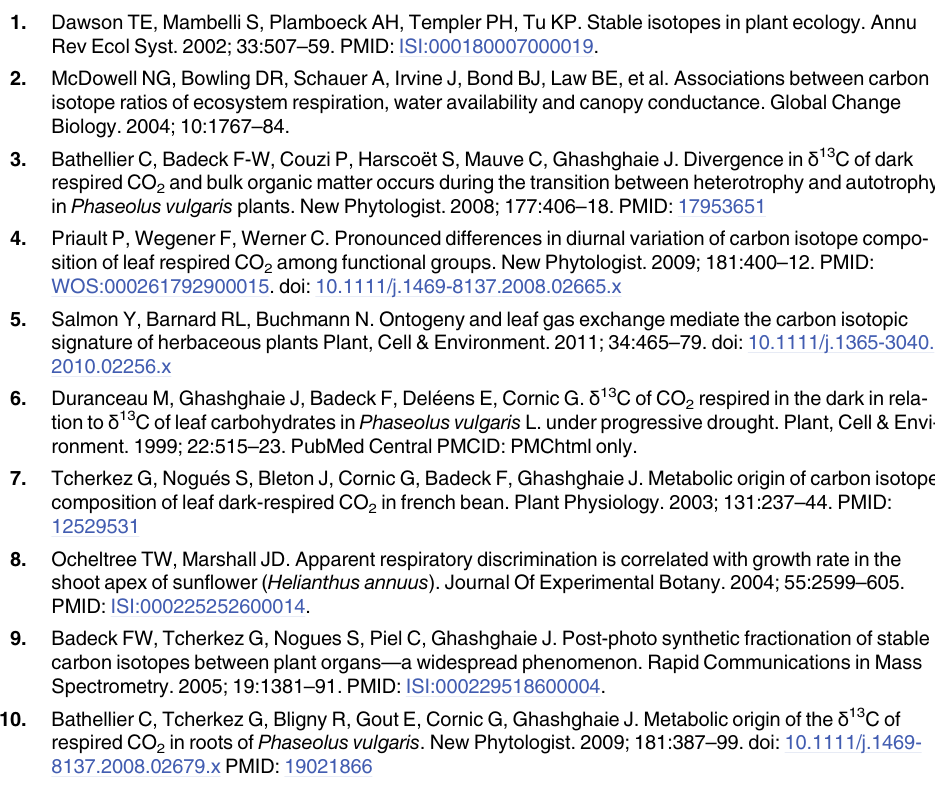
, A, g , Δ , B, LA and R . l s i s ) at three ontogenetic stages in seven spe- R